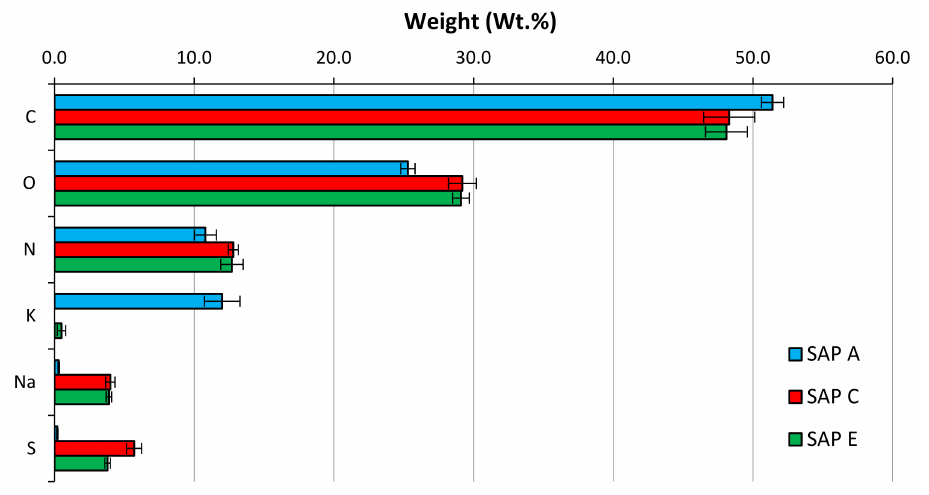
Figure 8. Chemical characterisation of SAP samples.